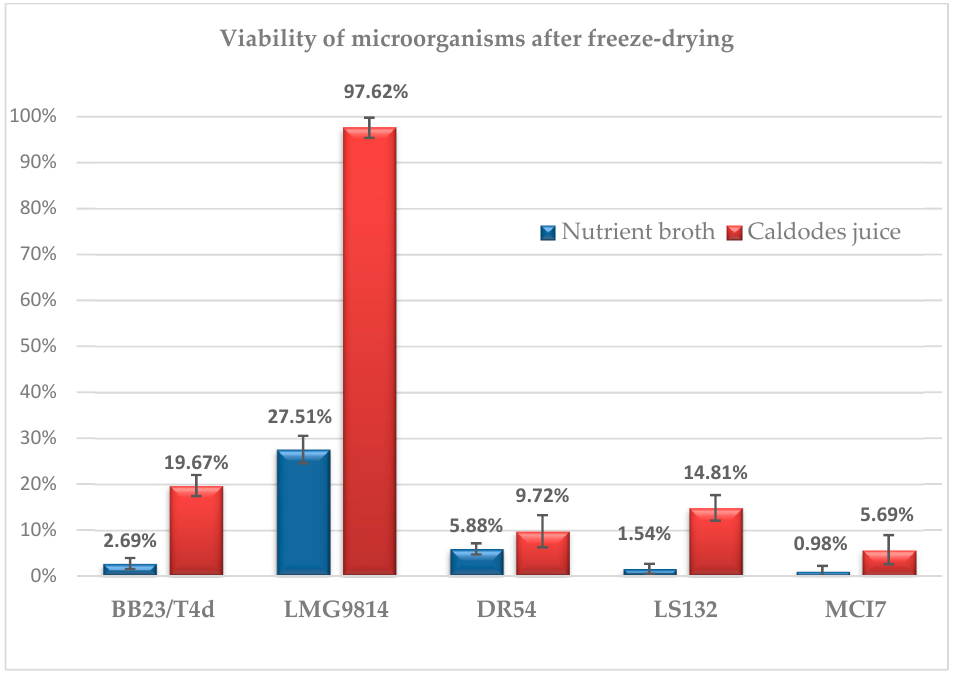
Figure 3. Percentage of survival of microorganisms grown on cladodes juice and Nutrient Broth after freeze-drying. Strains: R. aquatilis BB23/T4d, B. amyloliquefaciens LMG 9814, P. fluorescens DR54, A. chroococcum LS132, and B. ambifaria MCI 7.